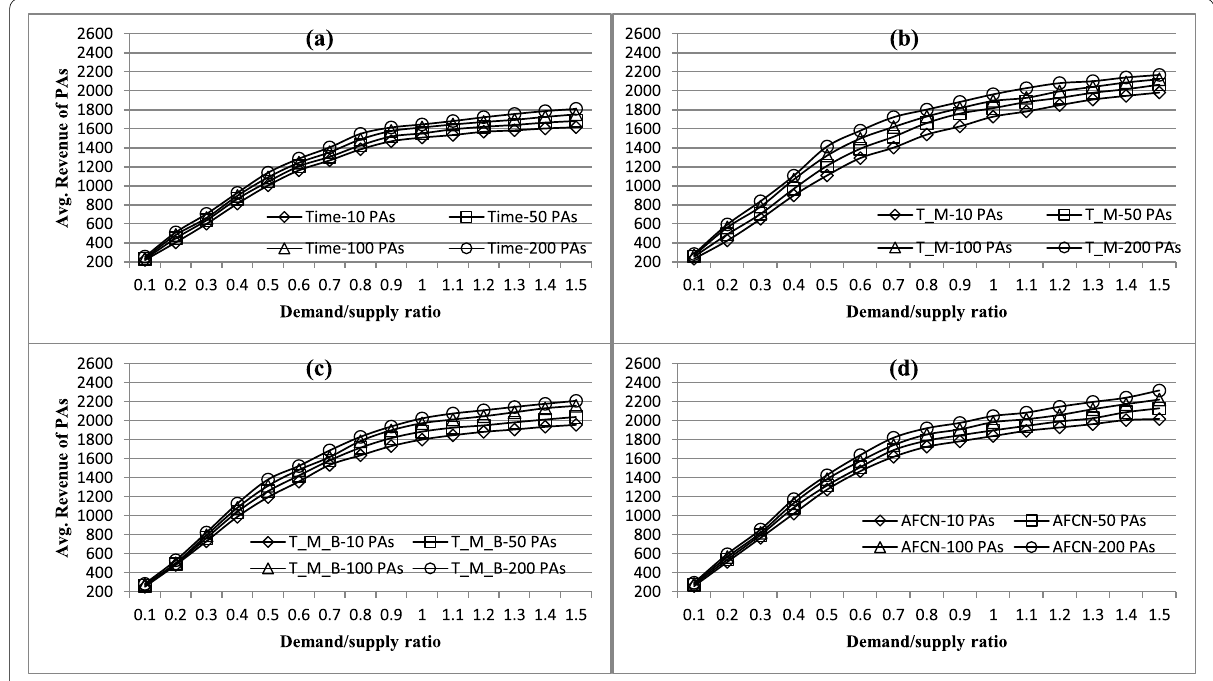
Fig. 16 Average revenue for different numbers of